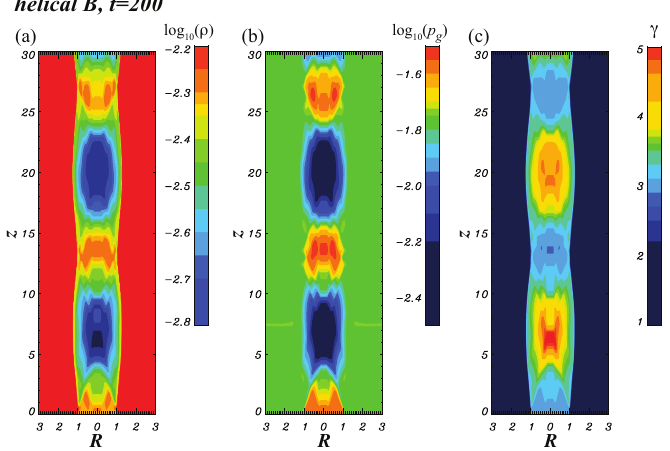
Figure 2. 2D plots of: ( a ) the rest-mass density; ( b ) the gas pressure; and ( c ) the Lorentz factor for 2D RMHD simulations of recollimation shock in over-pressured relativistic jet with helical magnetic field. Figure taken from [35].